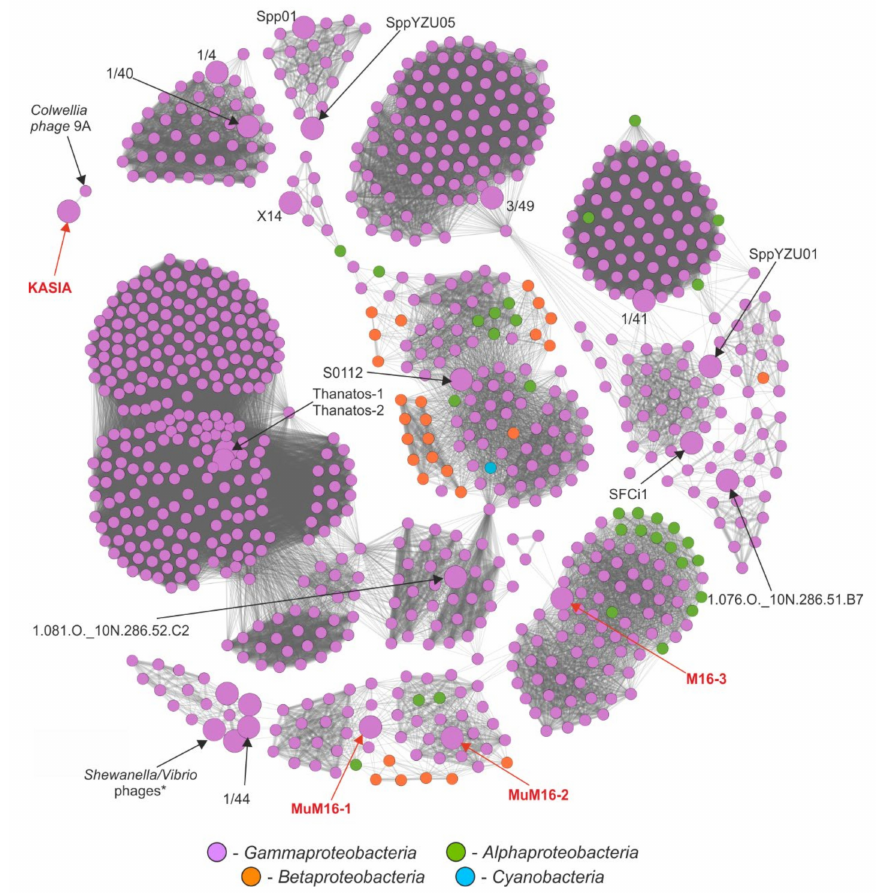
Figure 3. Protein-based phage similarity network. Only Shewanella -infecting phages and their neighborhood, i.e., phages showing significant similarity and connected with them via edges, are shown. Nodes, each representing a phage, corresponding to Shewanella phages, are enlarged and indicated with arrows, except for the Shewanella / Vibrio phages, which are indicated as a group of four phages. The coloring of the nodes is based on the taxonomic class of the phage hosts. The edge thickness reflects the degree of similarity between two phages (the greater the similarity, the thicker the edge), considered as an overall similarity of proteins encoded by a pair of